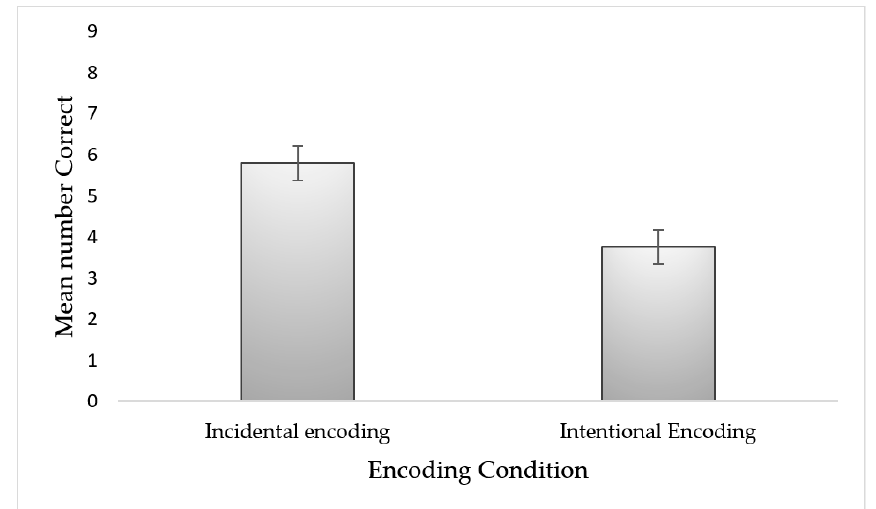
Figure 2. Mean number of correctly detected location-exchanged objects under divided attention incidental and intentional encoding conditions for the corrected scores. Error bars represent standard errors of the mean